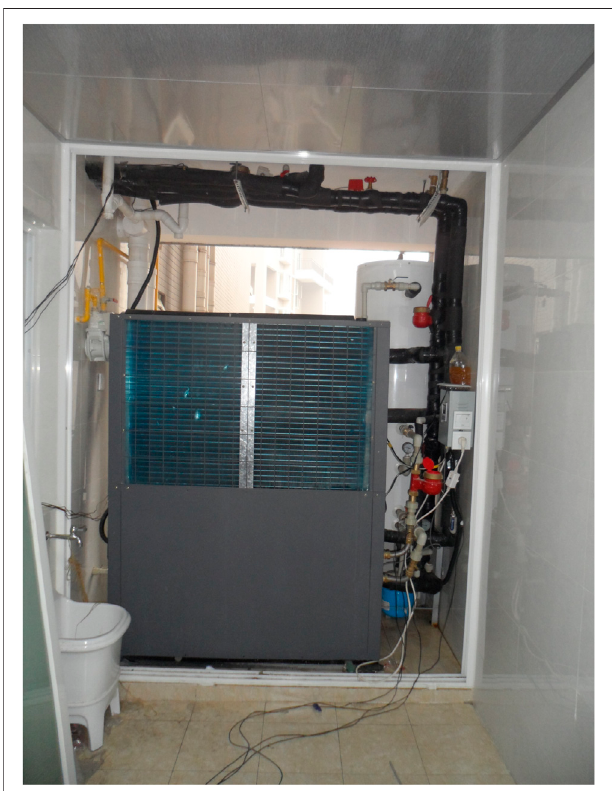
FIGURE 2 | Appearance of air source heat